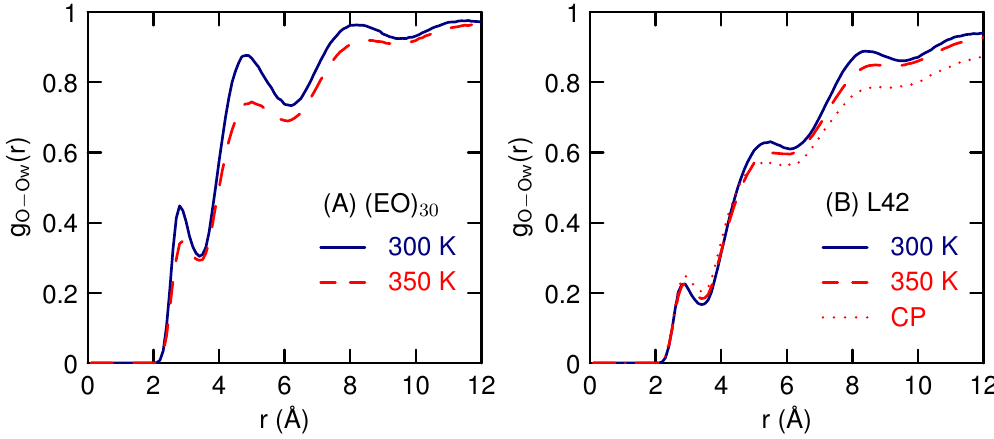
Figure 12. Water oxygen-polymer oxygen radial distribution function at different temperatures for dimers of ( A ) EO 30 and ( B ) L42. For L42, The results for The contact pair (CP) at 350 K are also shown. The correlation functions between atoms of different polymers are shown on Figure 13. At 300 K, the CH 2 carbons and the oxygen atoms do not get close to each other (consistent with Figure 8) and are a little farther apart for L42 than for (EO) 30 . At 350 K, the CH 2 –O and CH 3 –CH 3 pairs get closer and come into direct contact. The largest peak, at a distance of 3.7 Å, is between CH 3 –CH 3 , indicating the significance of the hydrophobic interaction on the transition to the contact